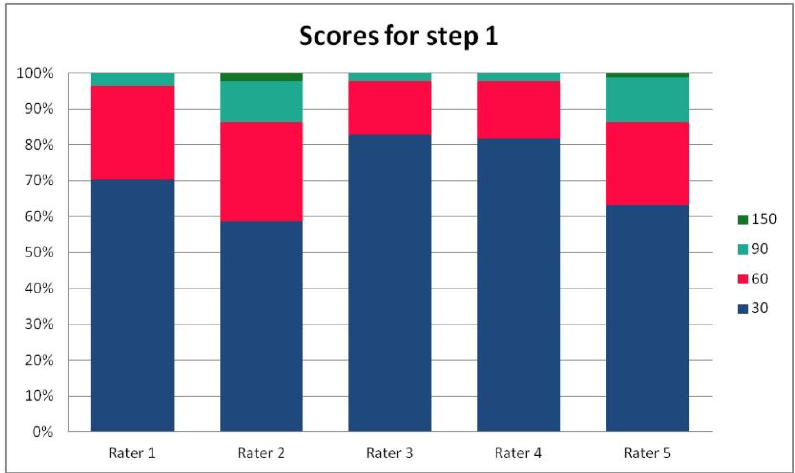
Figure 2. The percentage of ratings in the available categories given by individual raters for step 1 of the PRAETORIAN score.